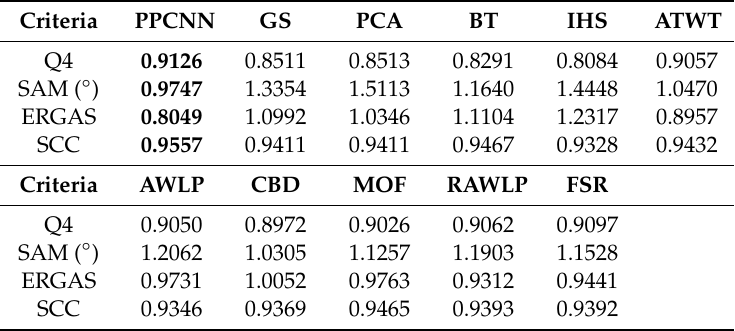
Table 4. Comparison results for Boulder